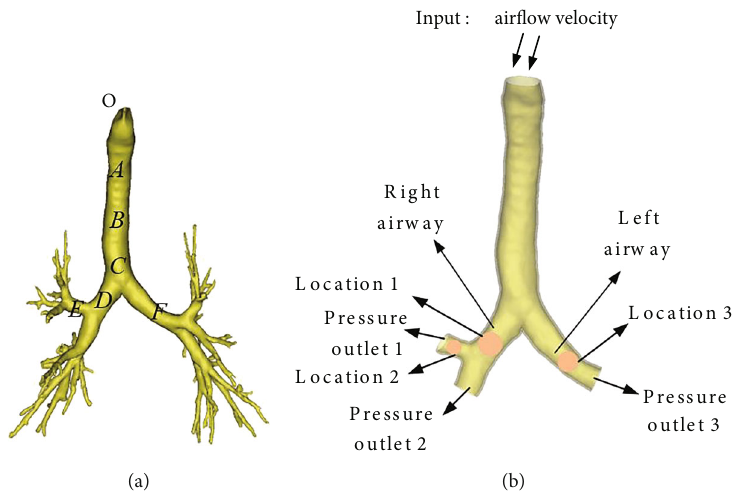
Figure 1: Reconstructed airway models: (a) unsimpli fi ed airway model, (b) simpli fi ed airway Table 1: Statistical table of measurement data at di ff erent positions of the trachea.